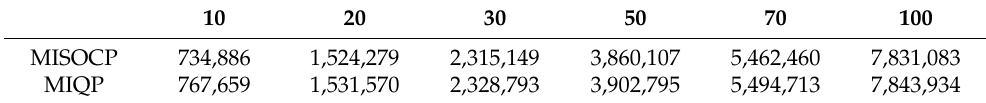
Table 3. Comparison of the total system cost for MISOCP and MIQP (USD).